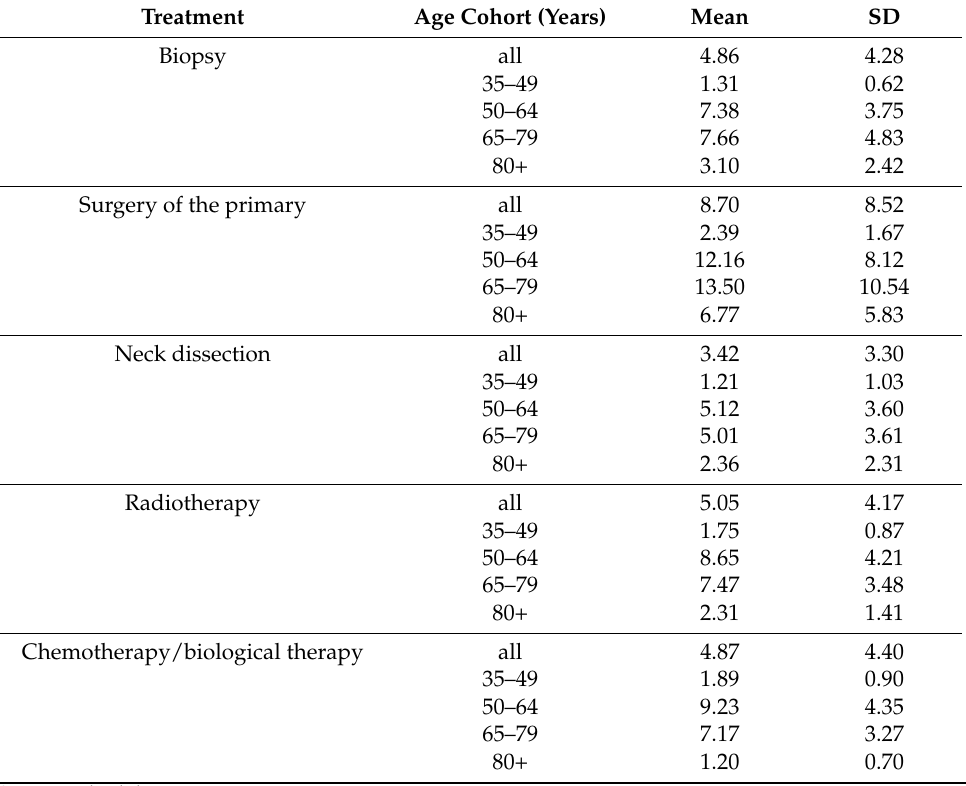
Table 1. Average treatment rates per 100,000 population of different age cohort for HNC treatment in Germany, for the years 2005–2018.